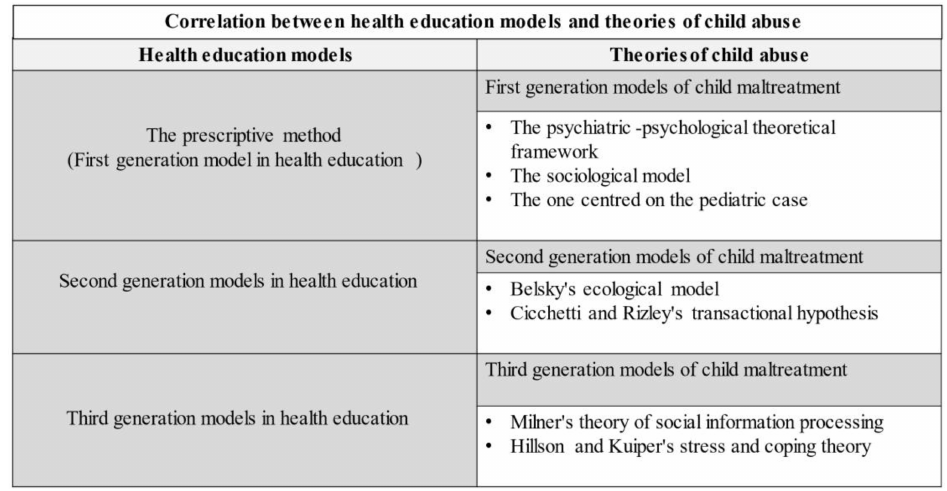
TABLE 4 Correlation of health education models and theories of child